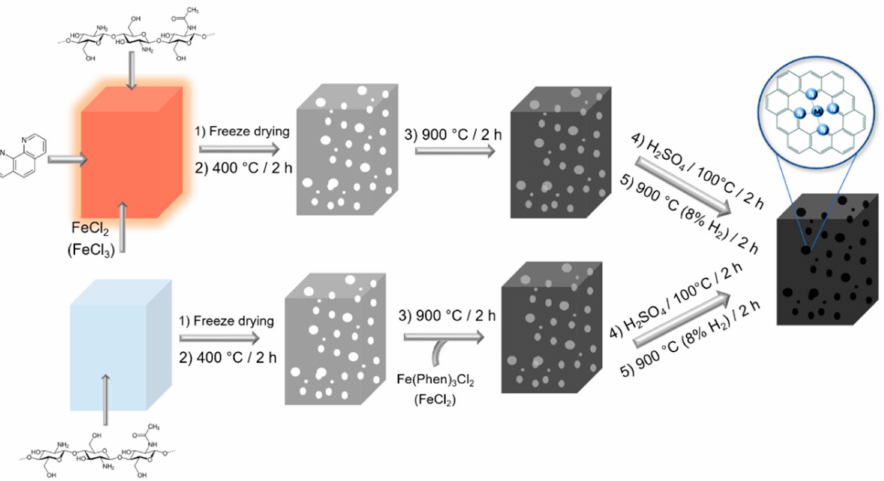
Scheme 1. Schematic representation of different steps for the synthesis of chitosan-derived Fe-N-C electrocatalysts. Table 1. Different synthetic conditions for chitosan-derived Fe-N-Cn (n = 1–5) electrocatalysts.